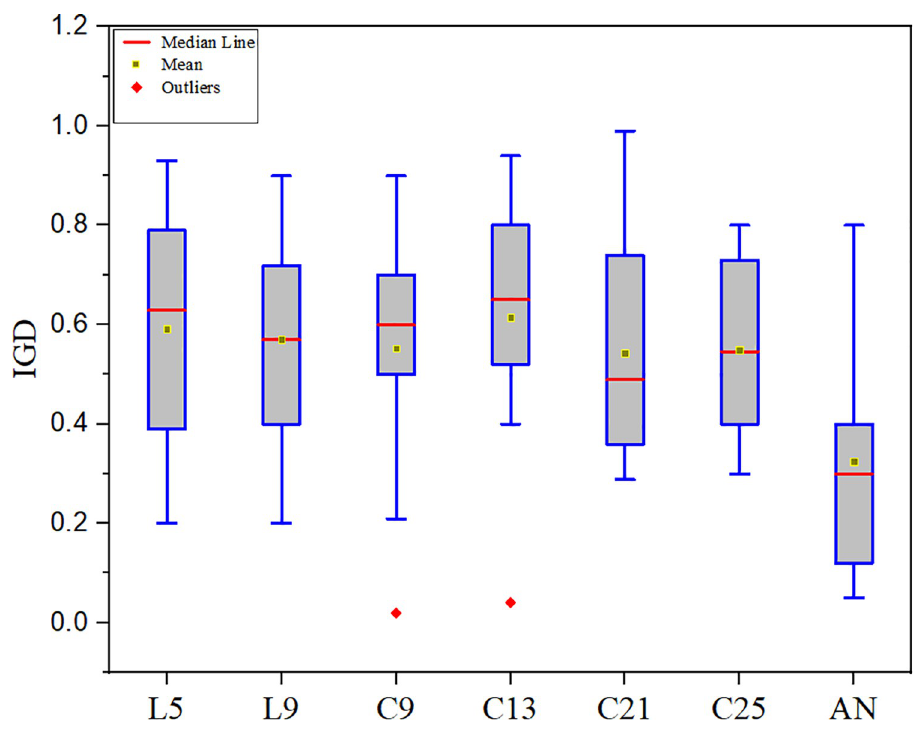
Fig 11. Box plot of IGD metric for different neighbourhood.